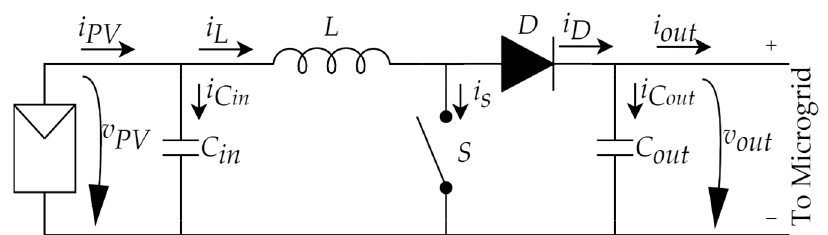
Figure 8. Schematic of implemented topology.